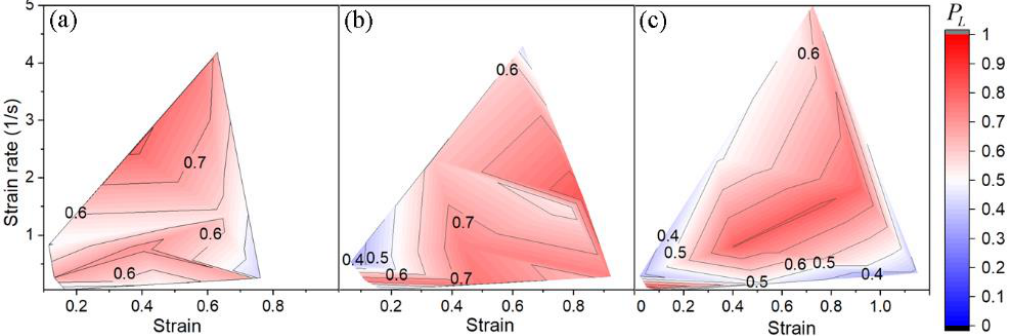
Figure 9. The effect of strain and strain rate on the average grain diameter depending on tempera- ture, °C: ( a ) 300, ( b ) 400, ( c ) 500. The dependences are plotted from the results of the EBSD analysis of the microstructure.